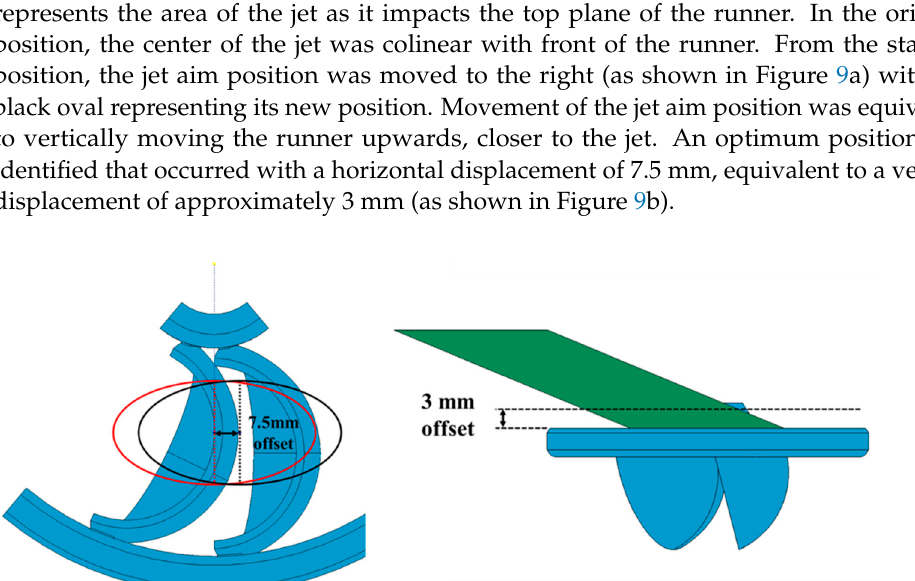
Figure 8. Efficiency against rotational speed for the imported turbine when operating at a head of 14.7 m.